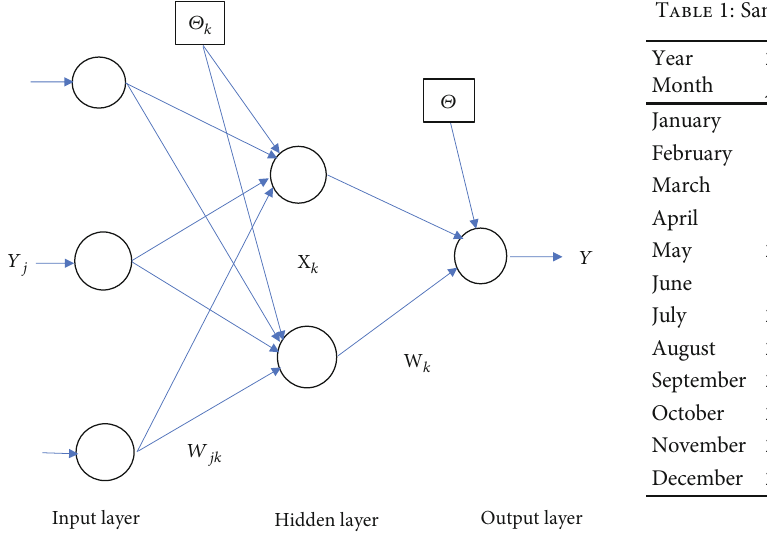
Figure 3: Feed-forward neural network for time series forecasting.